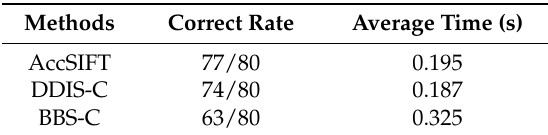
Table 4. Comparison to most recent studies on the Wuhan data.